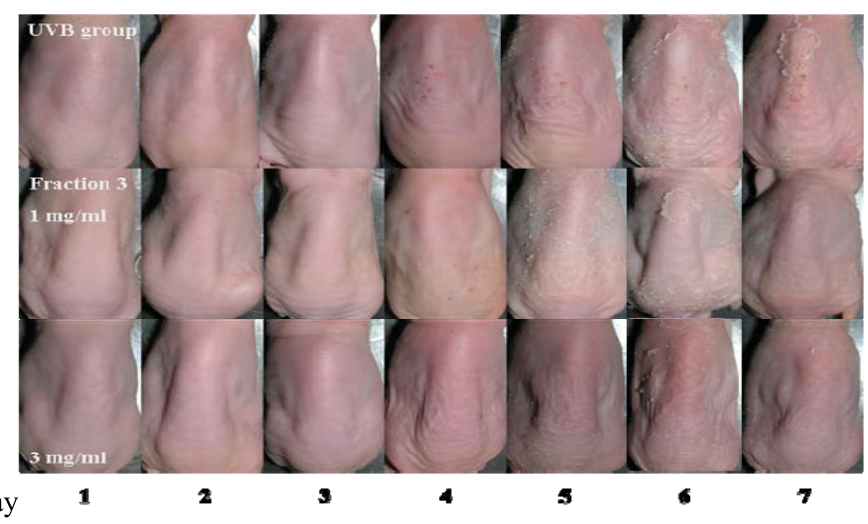
Figure 2. Photoprotective effects of Fraction 3 on UVB-induced pathological changes in the skin surface. Nude mice were treated with UVB irradiation in the presence or absence of Fraction 3 for seven days. One and three mg/ml of Fraction 3 was applied onto nude mice before UVB irradiation. Days after vehicle and Fraction treatment are